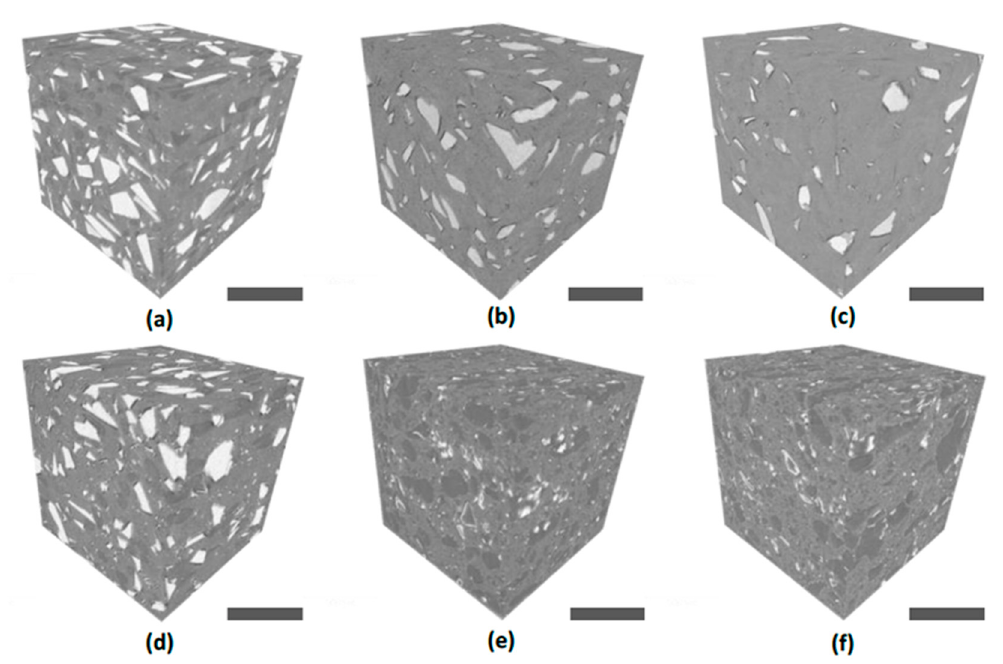
Figure 12. 3D images of PLA-BaG composites. Top row: Si-BaG50 ( a ) 0, ( b ) 20 and ( c ) 40 wk and bottom row: P-BaG35 ( d ) 0, ( e ) 20 and ( f ) 40 wk. Scale bar 500 µm.